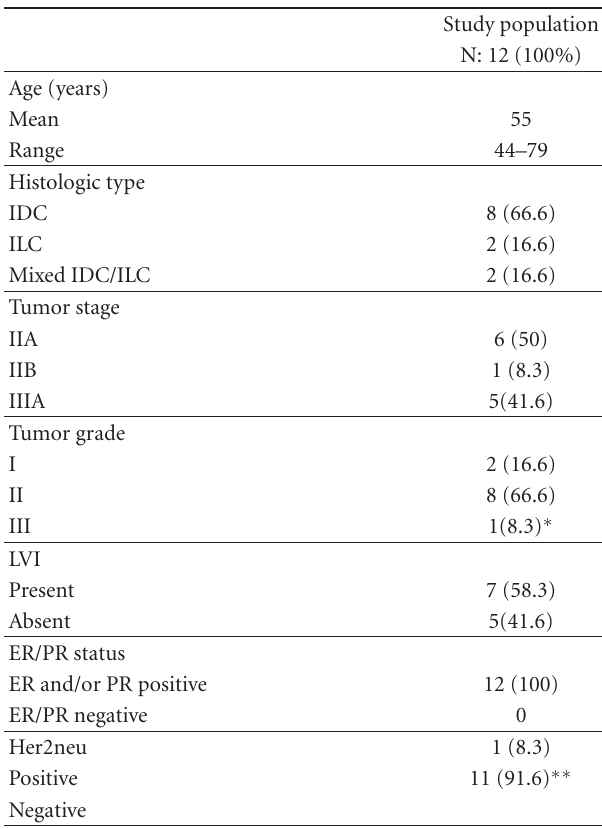
Table 1: Patient and tumor